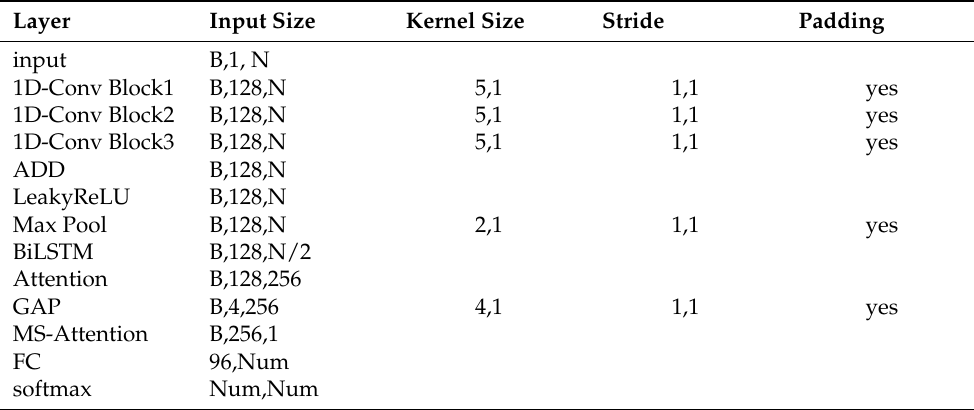
Table 3. The parameters of the MACNN-BiLSTM.